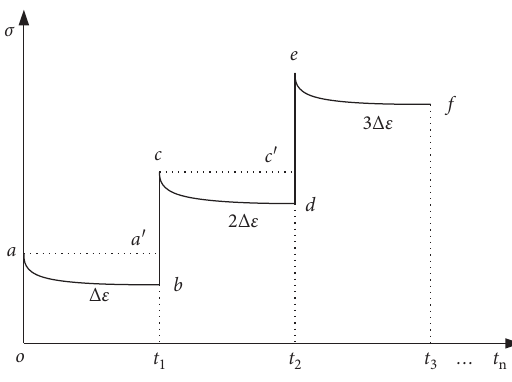
Figure 13: Stress-strain curve of 45 ° structural plane during